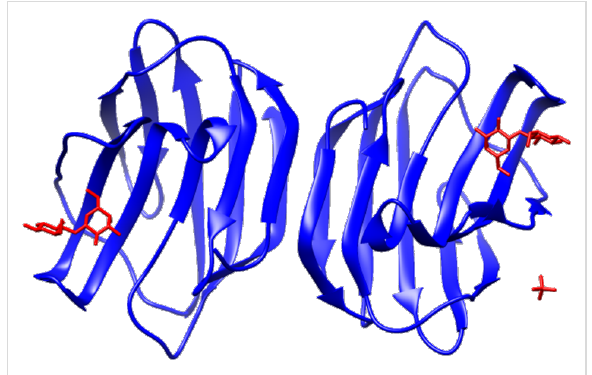
Figure 1: The structure of galectin-1. Reproduced with permission from [21]. Copyright 2004